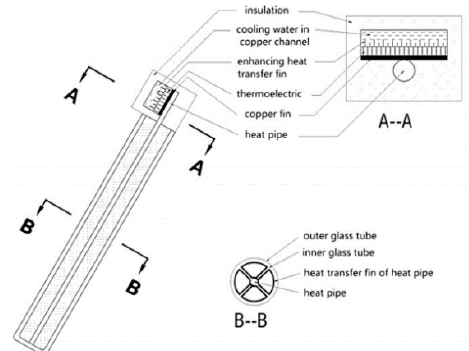
Figure 14. Schematic diagram of an integrated Solar Heat-Pipe/Thermoelectric (SHP-TE) system [155].